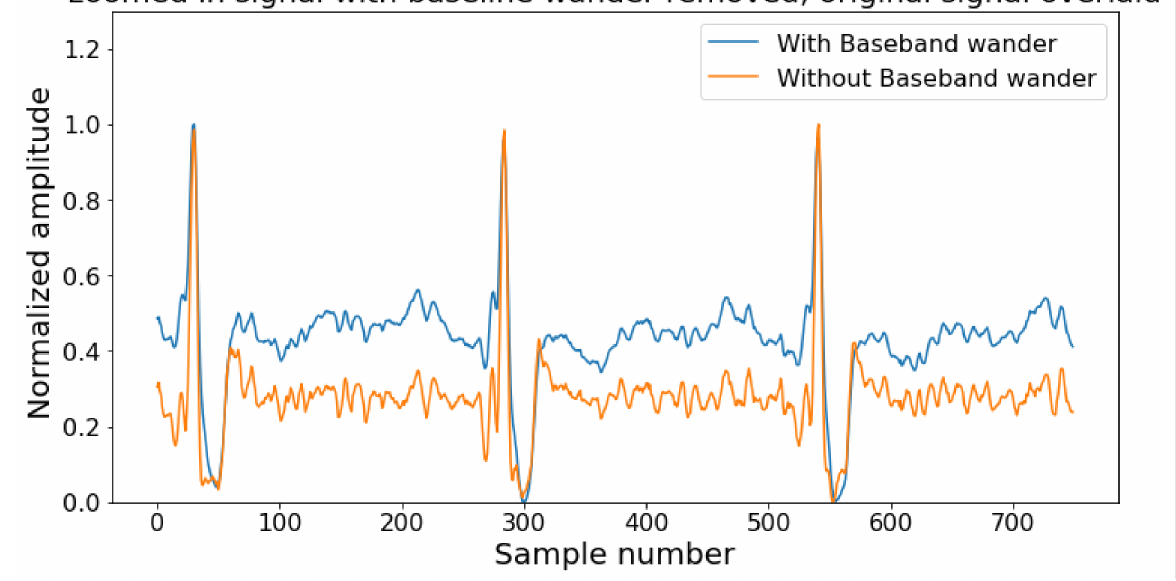
Figure 3. Example of normal noise-free and noisy